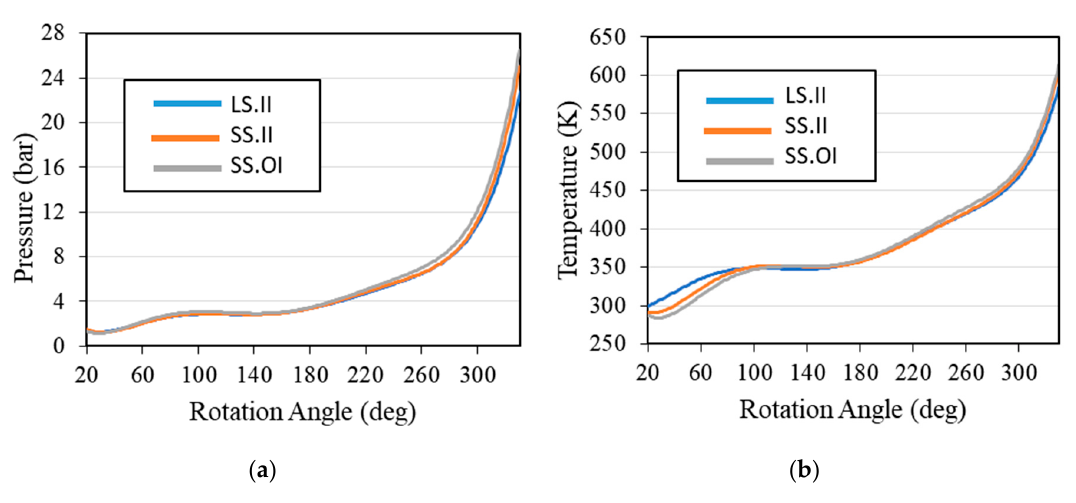
Figure 15. Pressure ( a ) and temperature ( b ) development in the compression chamber.